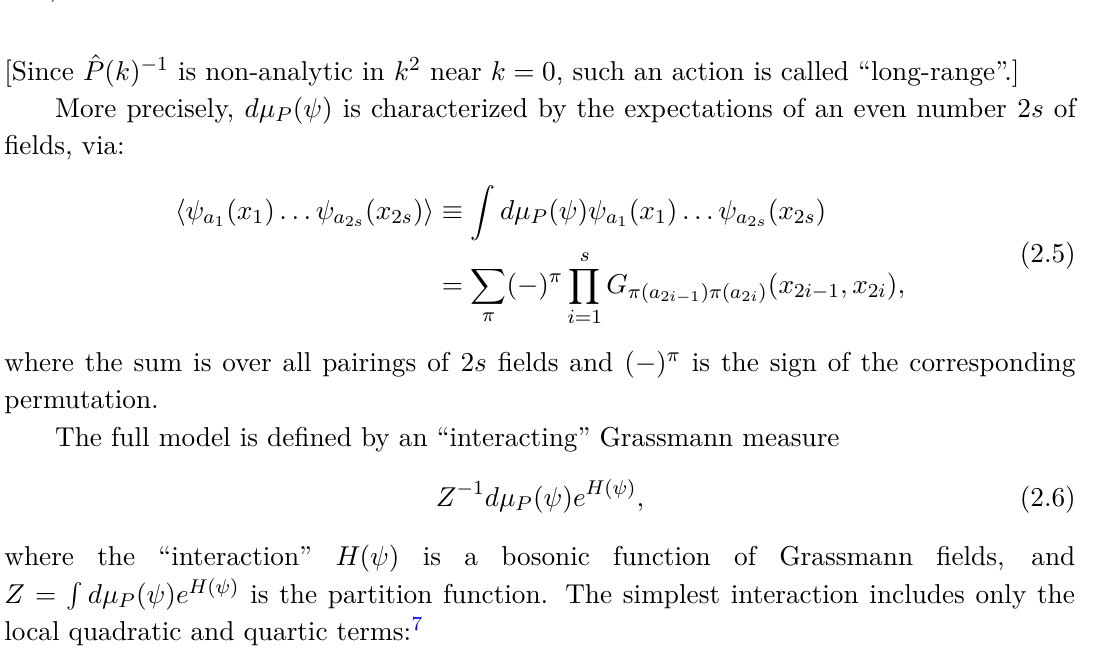
Figure 1. The function χ ( k ) (red curve), and the resulting function χ ( k ) − χ ( γk ) , eq. (2.10) (blue